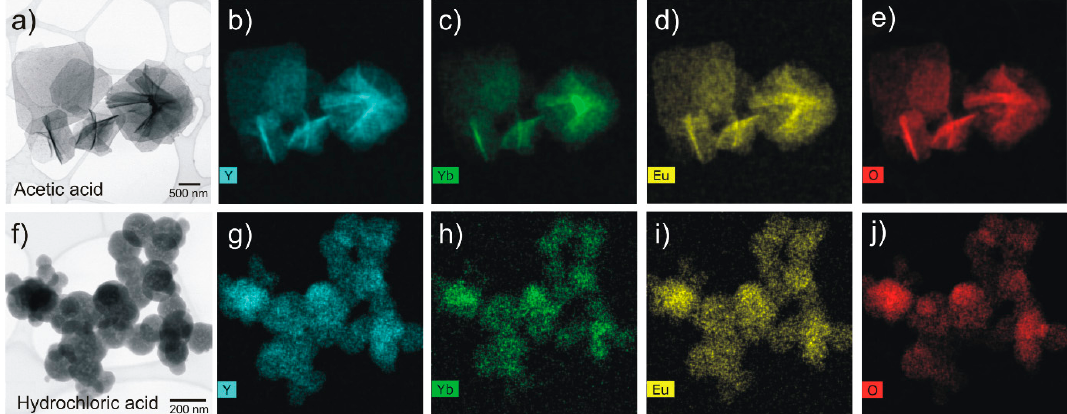
Figure 8. STEM images ( a ) and ( f ) and energy dispersive X-Ray spectroscopy (EDS) analyses of the Yb/Eu doped Y 2 O 3 nanostructures after microwave synthesis and calcination at 700 °C. The corresponding EDS maps for Y ( b ) and ( g ), Yb ( c ) and ( h ), Eu ( d ) and ( i ), and O ( e ) and ( j ) are presented. The two types of structures have been analyzed.